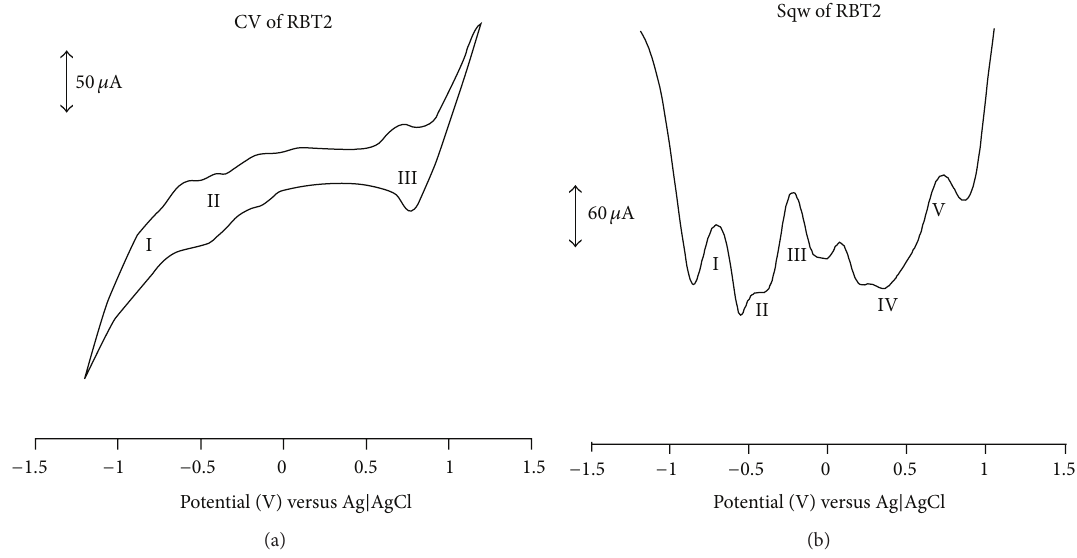
Figure 4: Cyclic and square wave voltammetry profiles of 1 × 10 −3 M of RBT2 complex in freshly distilled DMF containing 0.1M TBABF 4 supporting electrolyte. Step potential: 5 mV, amplitude: 50 mV versus Ag | AgCl, and frequency: 10 Hz. Scan rate: 100m Vs −1 versus Ag |